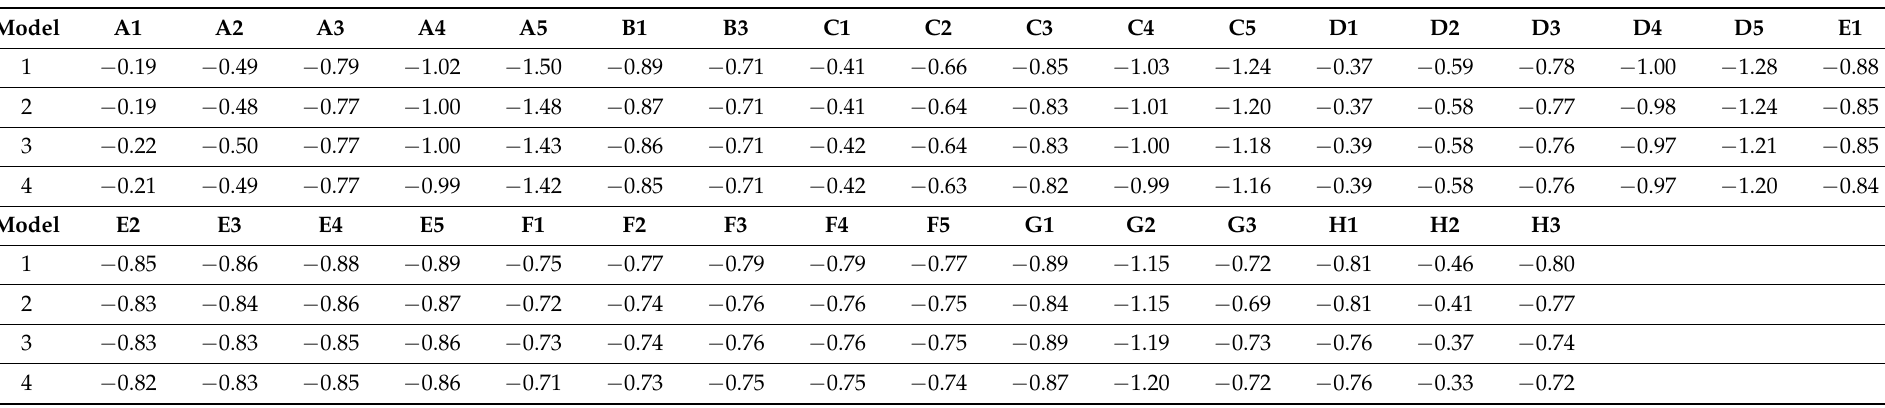
Table 2. Results, average value, and sum of displacements in the X direction at characteristic measurement points, obtained in the numerical simulation of the welding process of the furnace wall